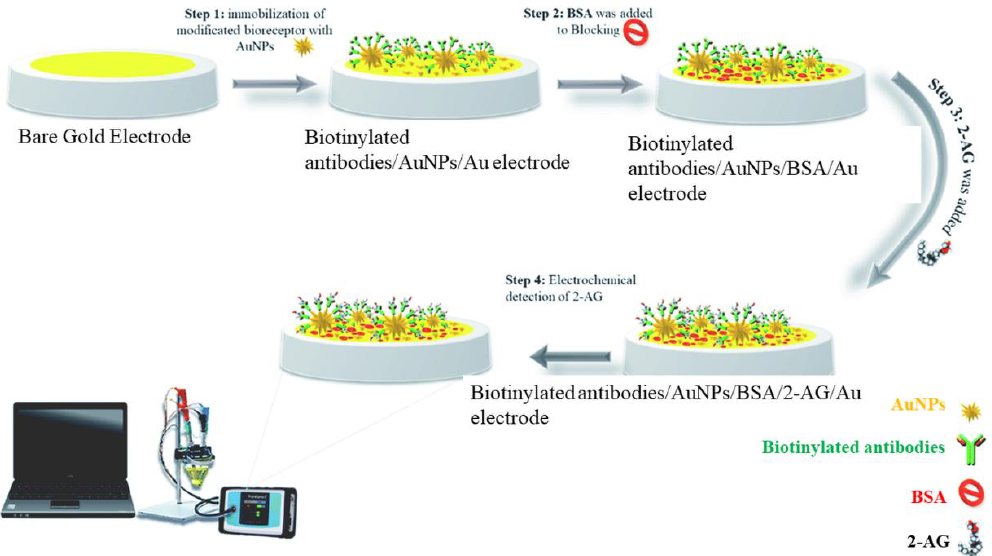
Figure 1. Schematic representation of the immunosensor proposed by Kohansal et al. for the detection of 2-Ag protein conjugate. Reproduced with permission from [64]. This article is licensed under a Creative Commons Attribution 3.0 International License, which permits use, sharing, adaptation, distribution, and reproduction in any medium or format, as long as you give appropriate credit to the original author(s) and the source, provide a link to the Creative Commons license, and indicate if changes were made. The images or other third party material in this article are included in the article’s Creative Commons license unless indicated otherwise in a credit line to the material.